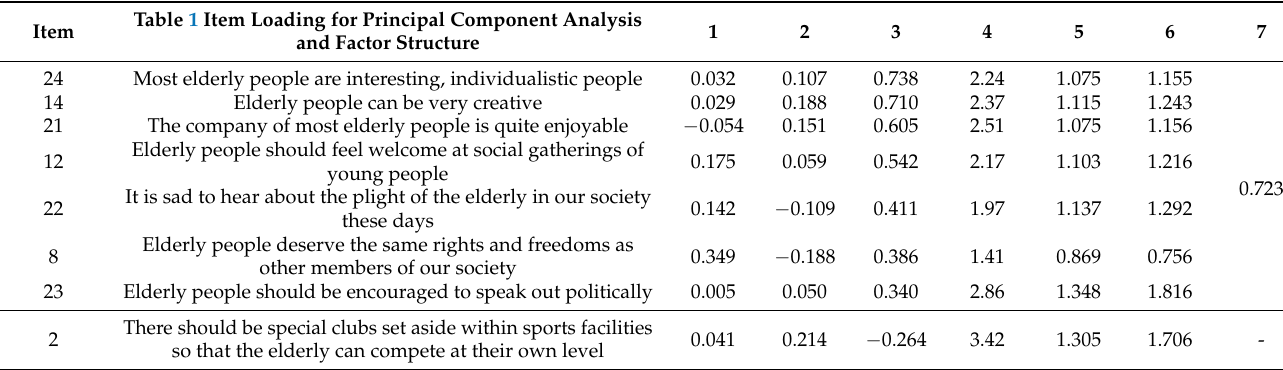
Table 1 Item Loading for Principal Component Analysis and Factor Structure